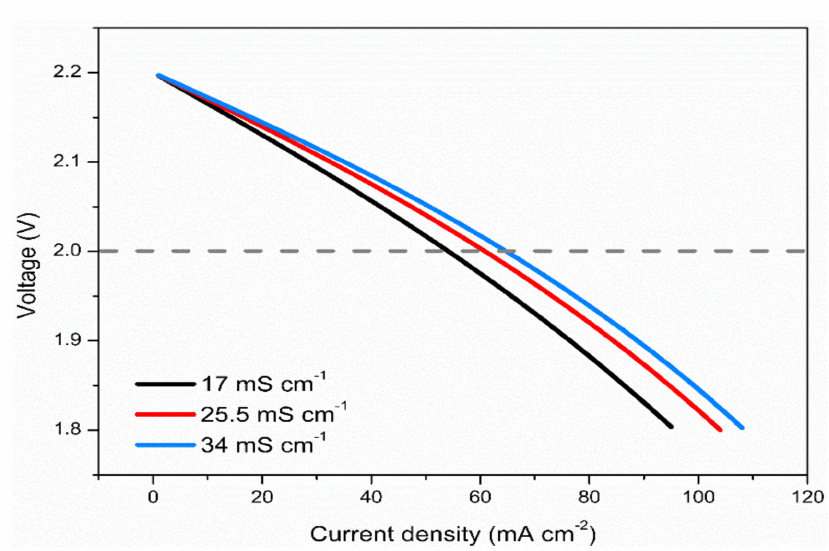
Figure 9. Effect of different membrane conductivities. Electrolyte: 100 mM V(acac) 3 in 500 mM TEABF 4 ; SOC: 50%; flow rate: 25 mL min − 1 ; temperature: 300